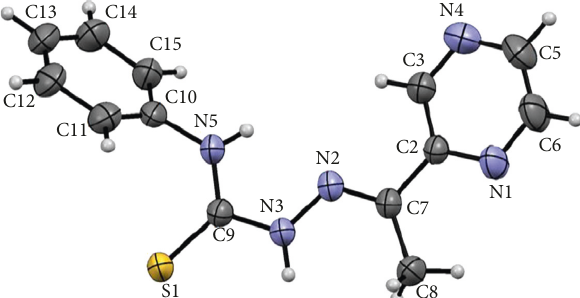
2 Table 2: Selected bond lengths and angles of H